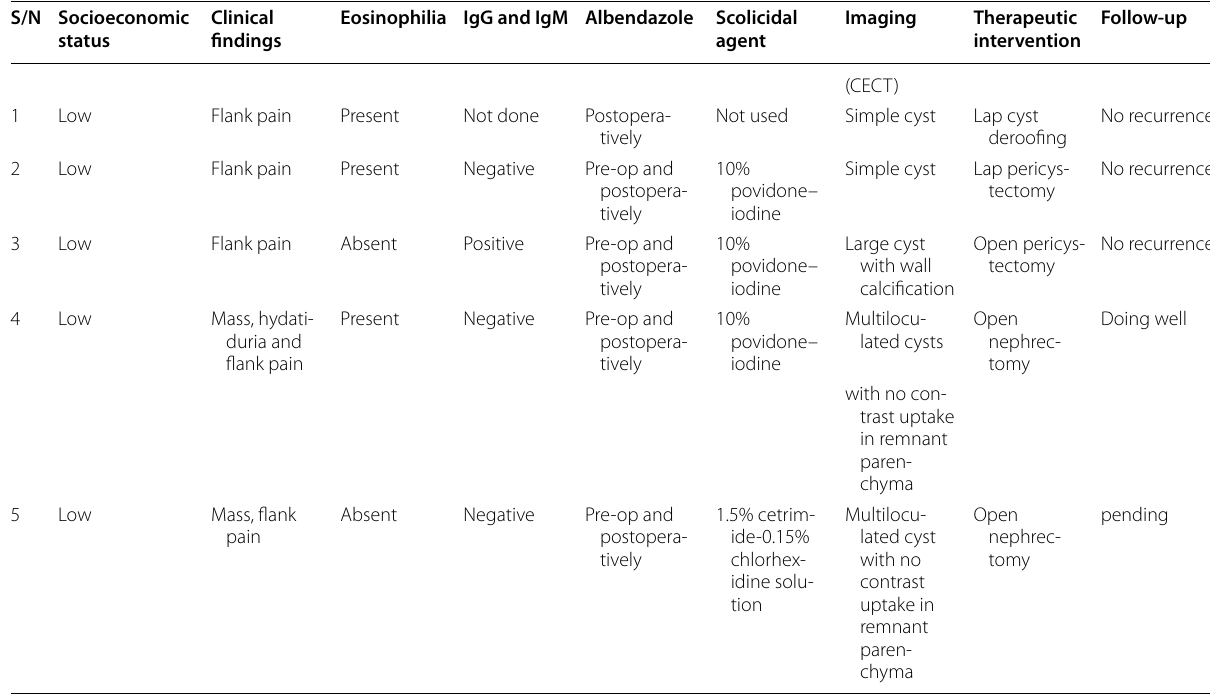
Table 1 Summarization of patient characteristics and treatment offered S/N Socioeconomic status